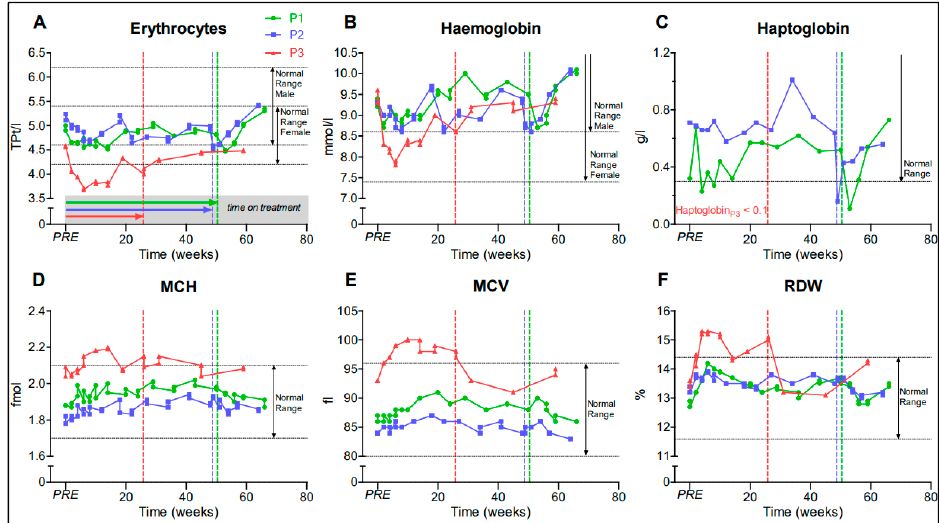
Figure 1. Graphs A-F represent hematology parameters. Patients 1–3 (P1–3), PRE represents baseline value before initia- tion of dasatinib treatment, dotted vertical lines represent individual end of treatment. Mean corpuscular volume (MCV); mean corpuscular hemoglobin (MCH); red blood cell distribution width (RDW).